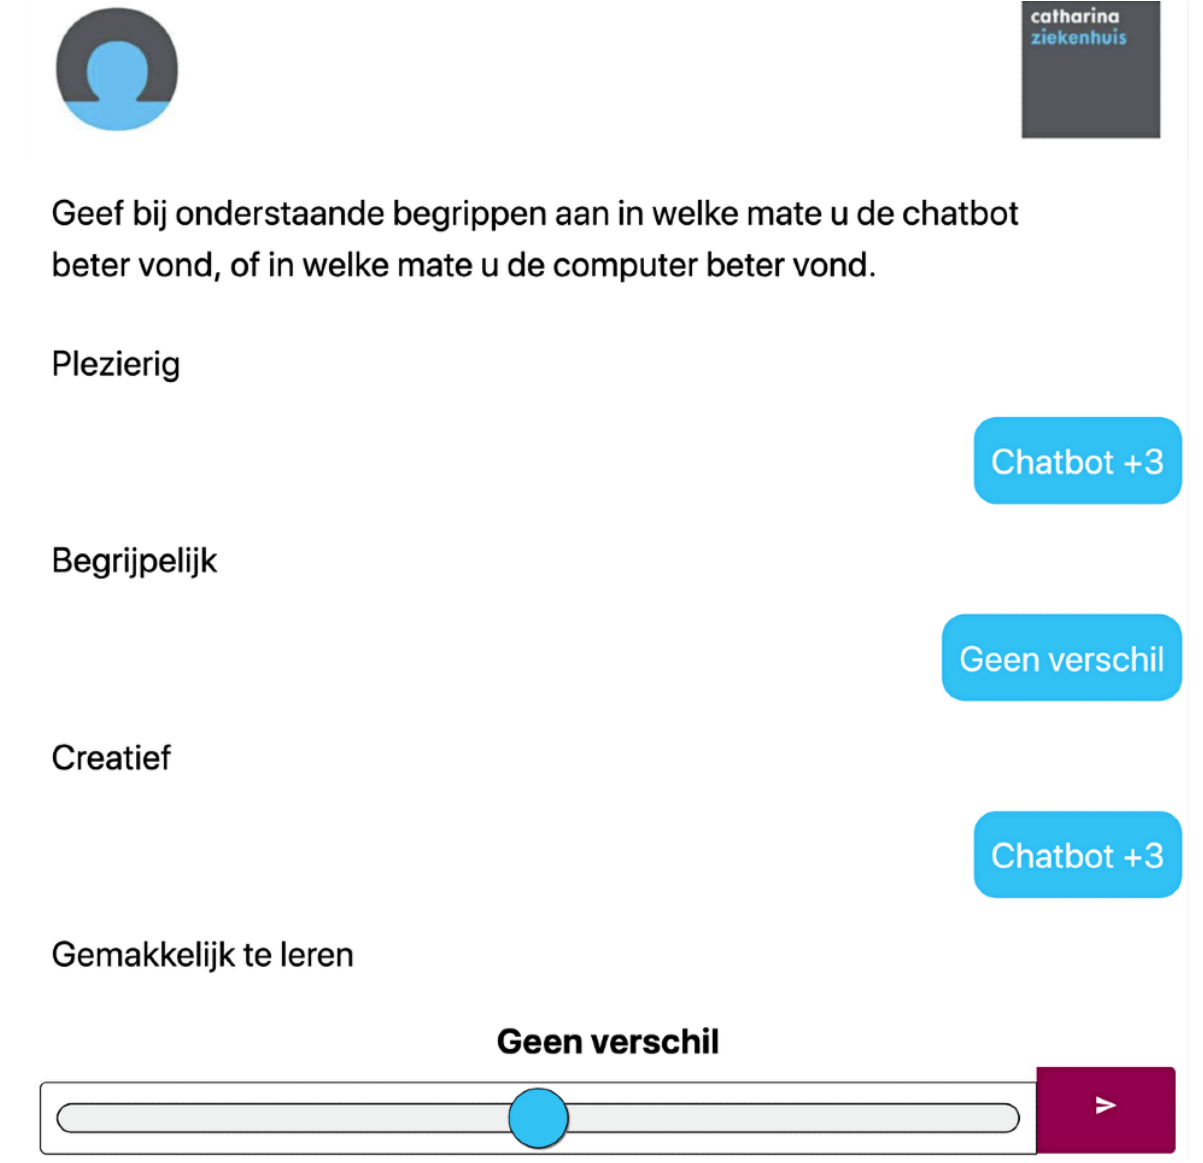
Figure 3. User Experience